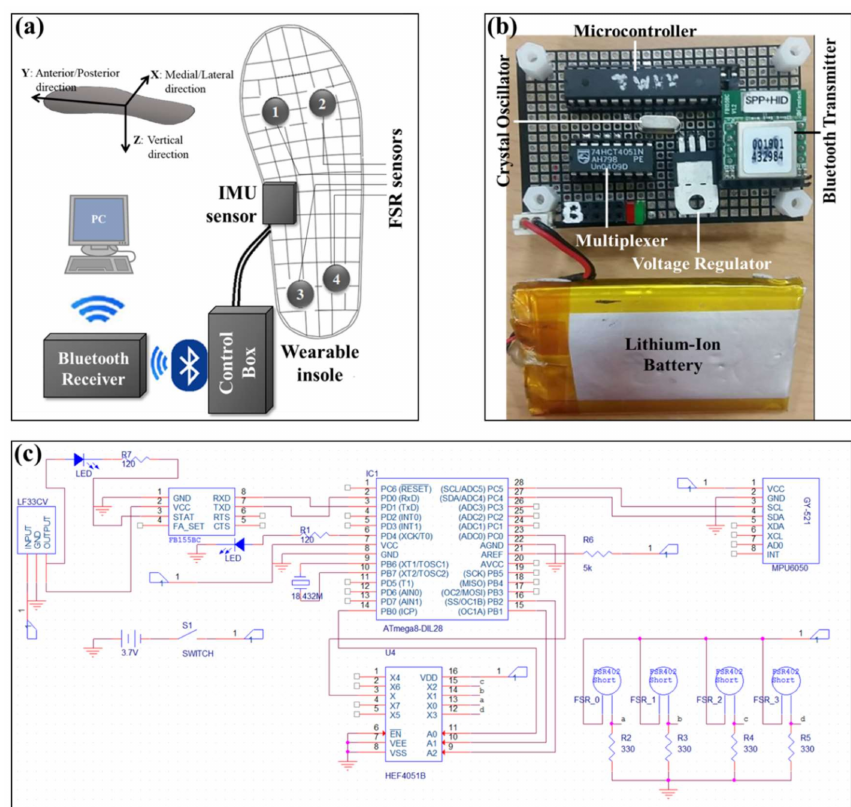
Figure 1. ( a ) Overview of the Hardware System: an insole system comprised of a single Inertial Measurement Units (IMU) and four force-sensitive resistors (FSR) sensors, connected to a control box where a microcontroller calculates sensor measurements, then sends those measurements via Bluetooth to the Bluetooth’s receiver, which collects the streamed data for use in fall detection; ( b ) the contents of the control box; and, ( c ) circuit diagram of the hardware